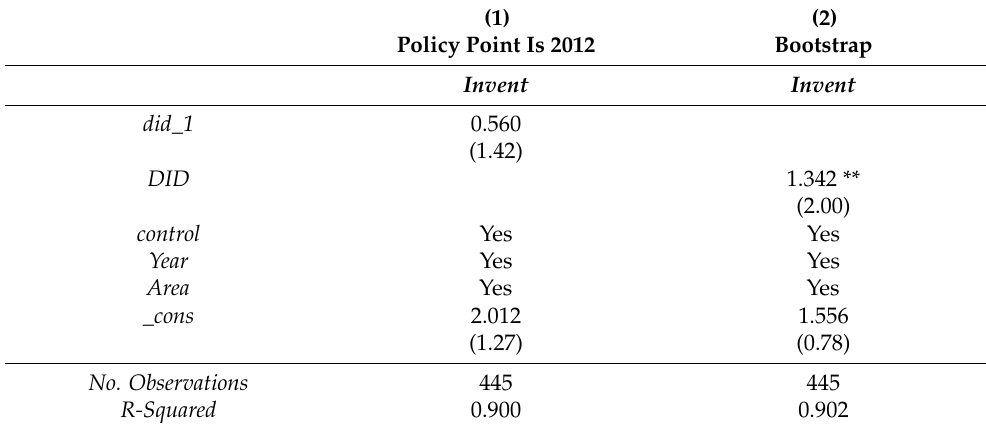
Table 3. Robustness tests: timing of policy change onset and mitigation of serial correlation issues.